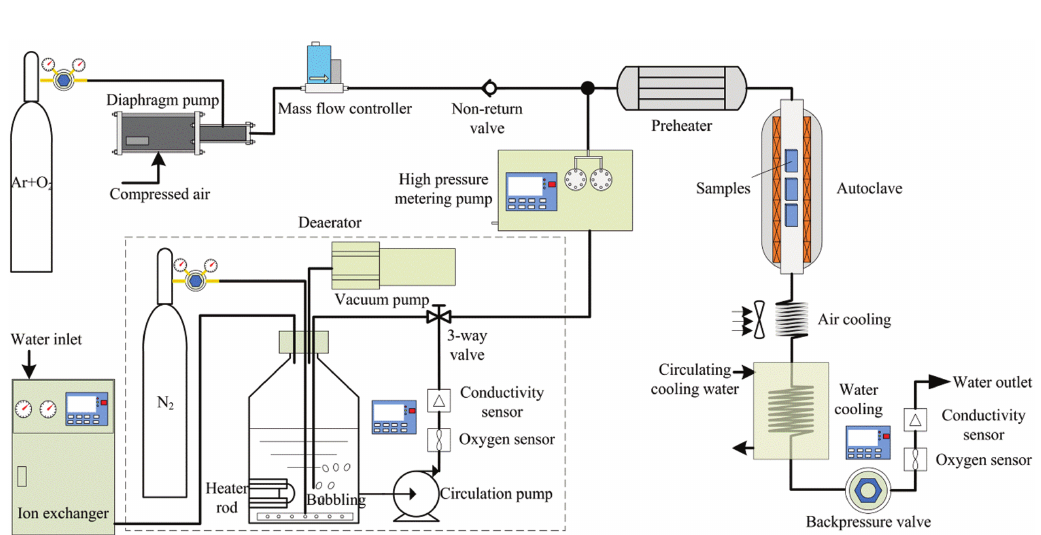
Figure 1: Schematic diagram of the SCW oxidation testing